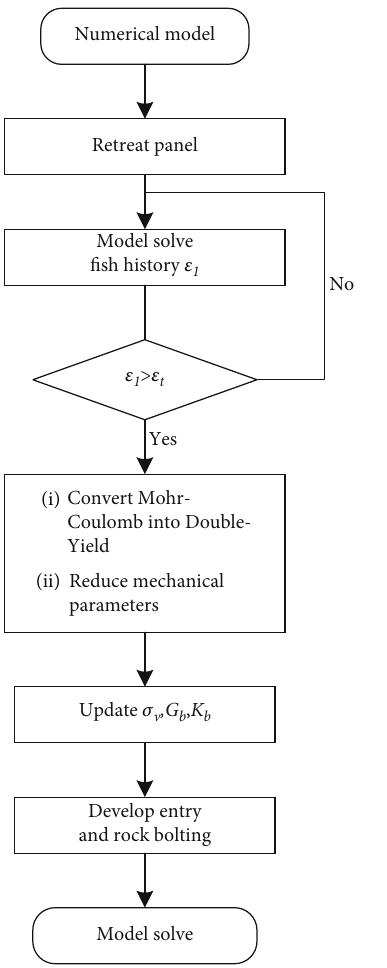
Figure 8: Numerical simulation process by FLAC3D.